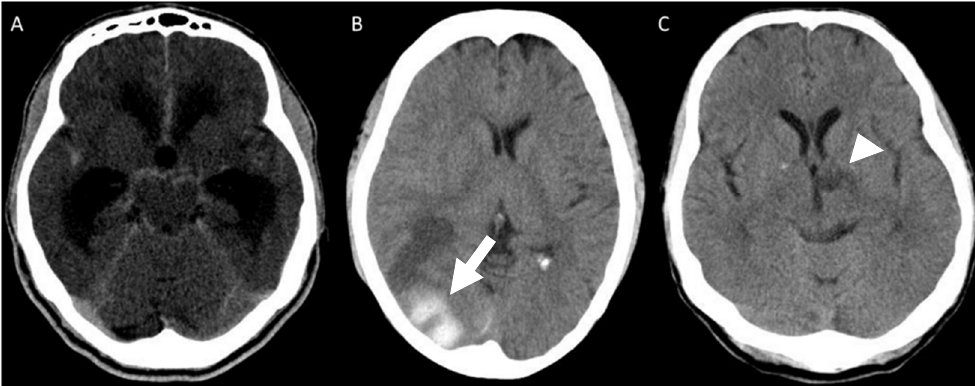
Figure 3. Brain CT scan showing A) ventricular dilatation and basal cisterns contrast enhancement; B) a parieto-occipital hemorrhagic lesion (white arrow) and C) left thalamic ischemic lesion (white arrowhead).